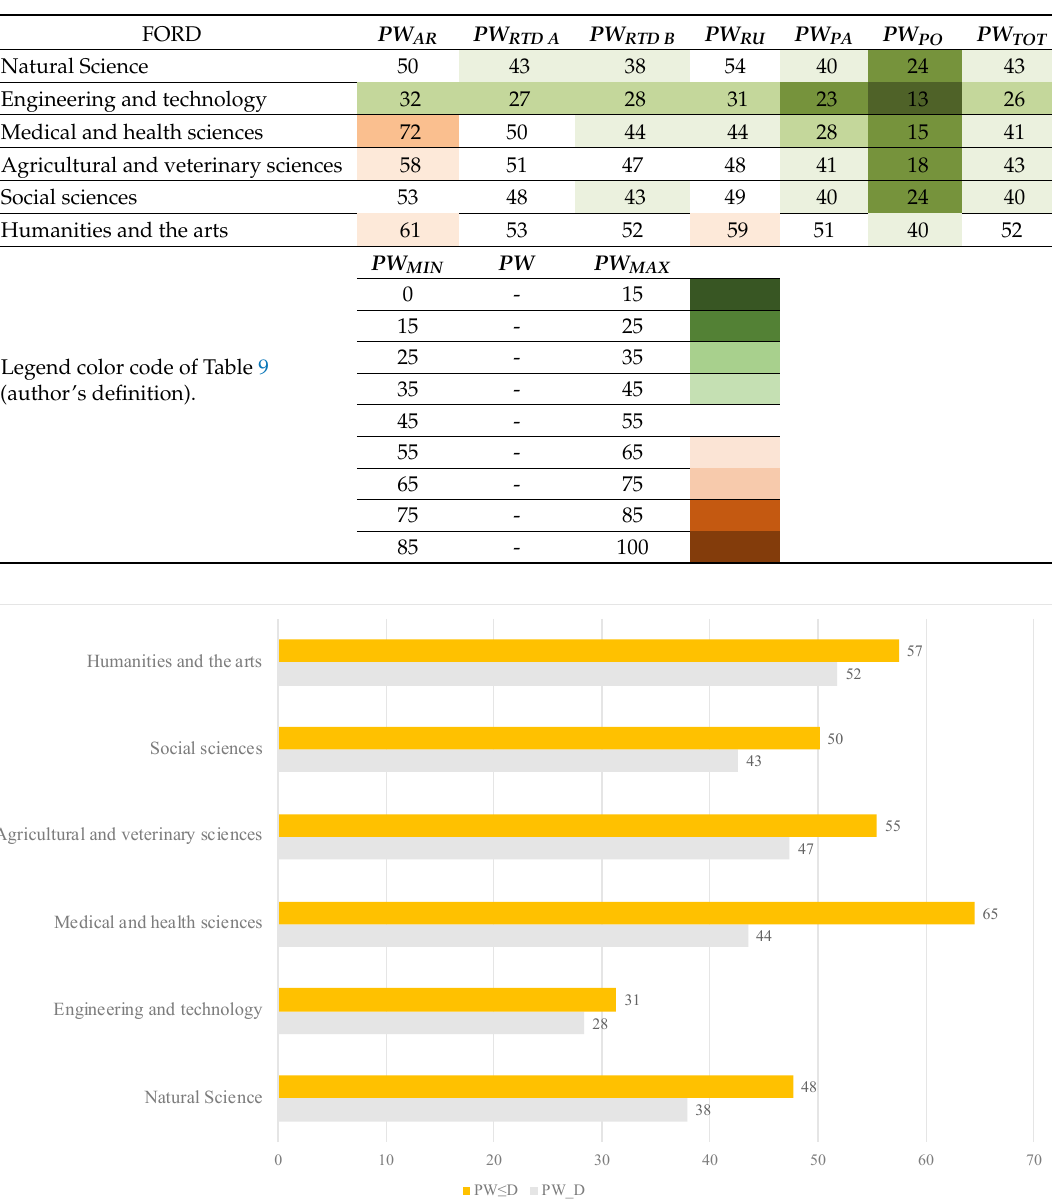
Table 9. Proportion (%) of women by an academic role in the main FORDs defined by the Frascati Manual (OECD 2002) (author’s elaboration on MIUR data, 2017).